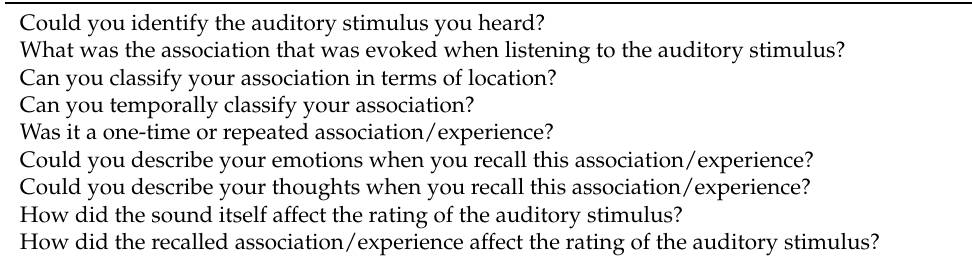
Table 2. List of the interview